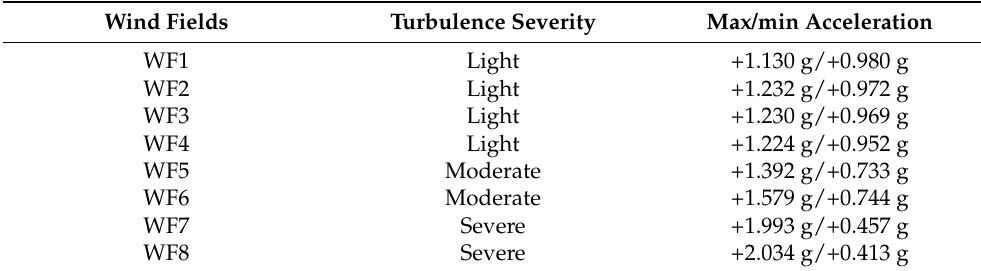
Table 2. Selected eight wind